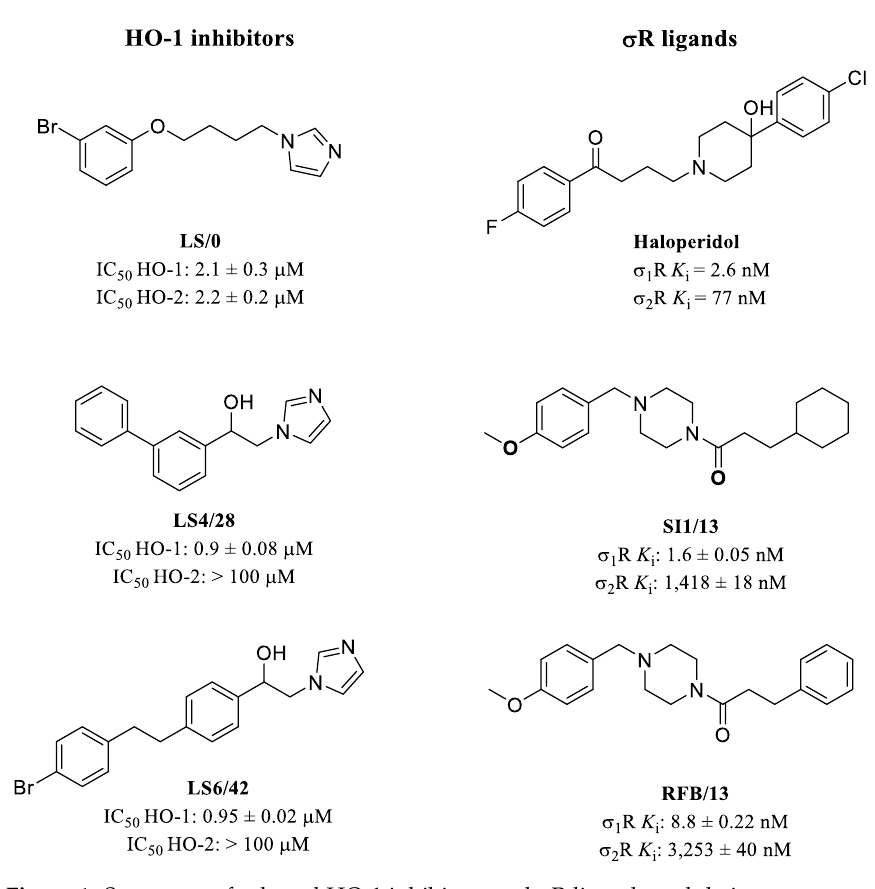
Figure 1. Structures of selected HO-1 inhibitors and σ R ligands and their potency against respective targets.